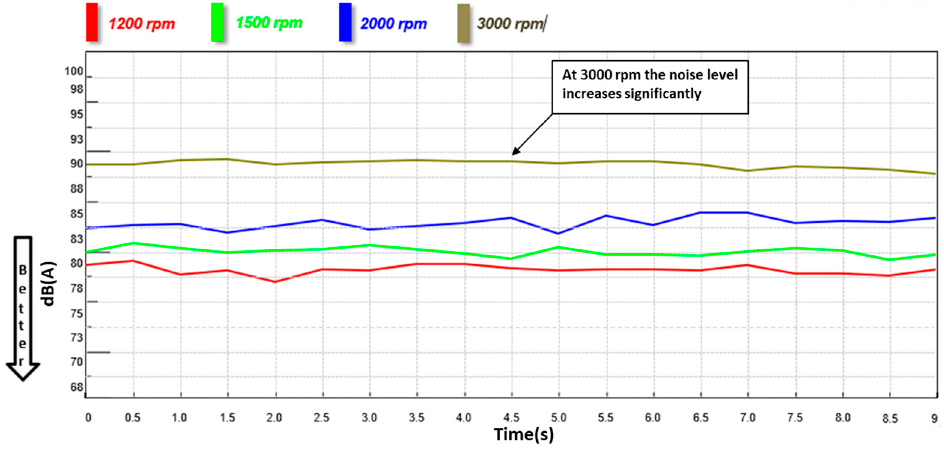
Figure 5. Engine upper-side noise level at constant rpm.